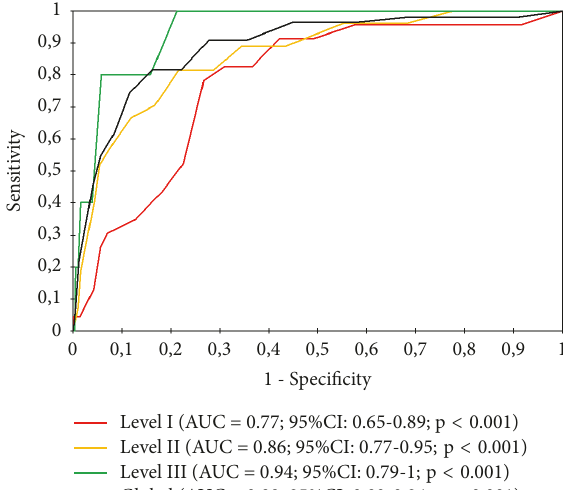
Figure 2: Diagnostic performance curves and areas under the curve with 95% confidence intervals for NEWS and Spanish triage system. Mortality less than 2